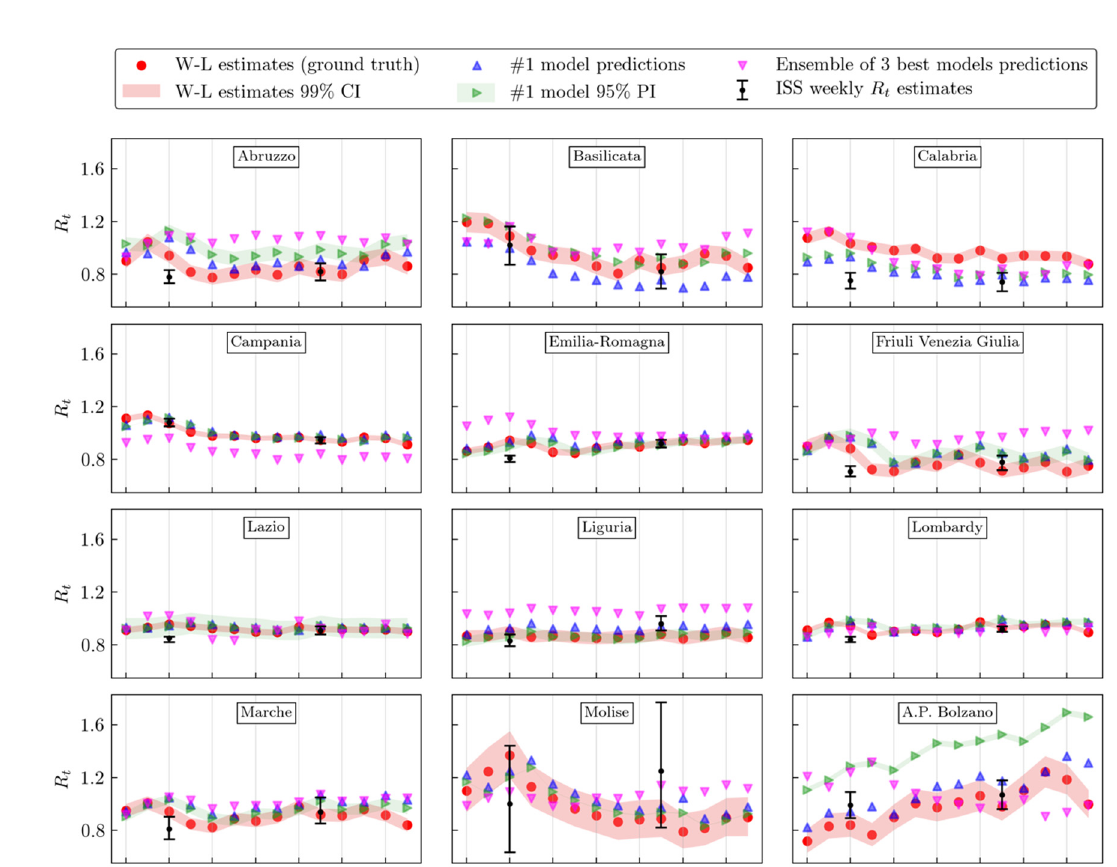
Figure 3. Lombardy Model evaluation. Predictions obtained by means of the regional three best models and their average ensemble model are compared with Wallinga–Lipsitch R t estimates in the period from 4 February 2021 to 11 April 2021. The endemic threshold ( R t = 1) is also reported.